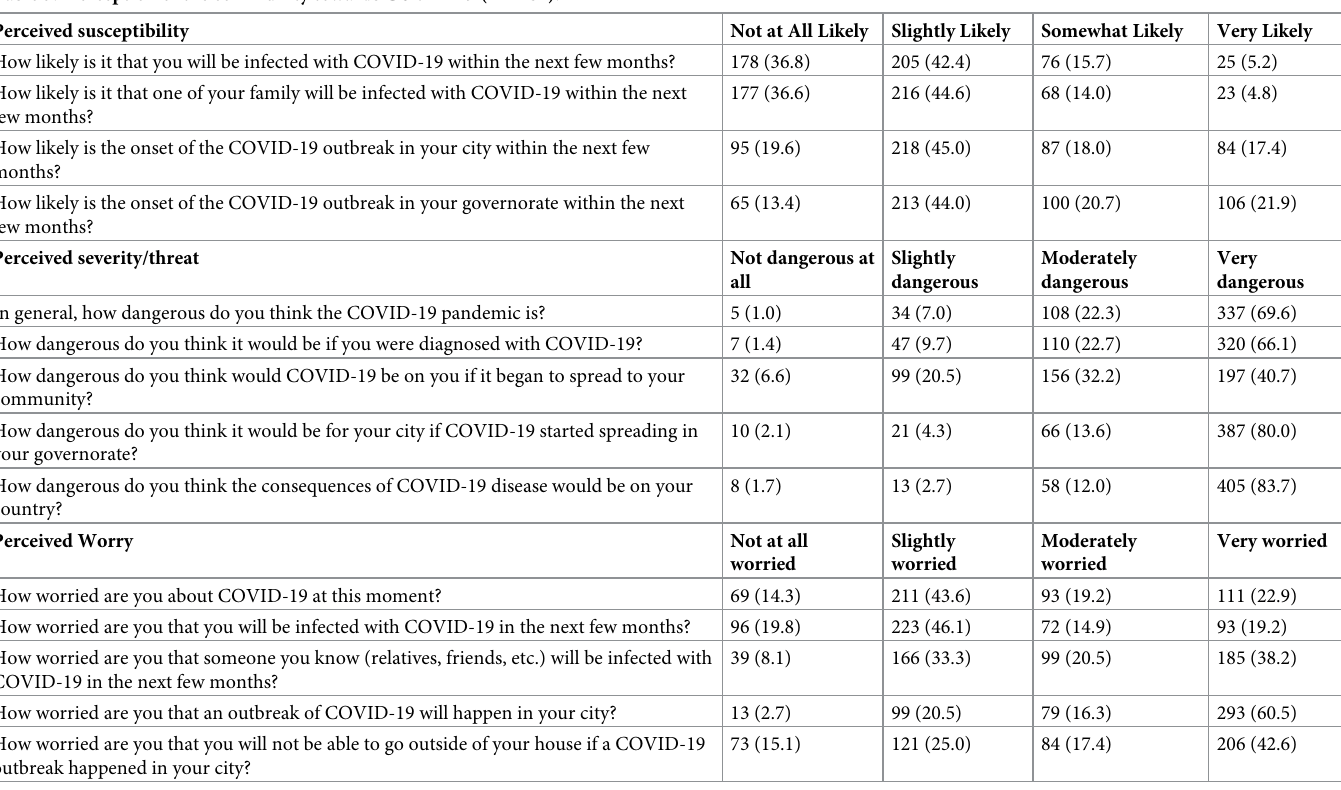
Table 3. Perception of the community towards COVID-19 (n =